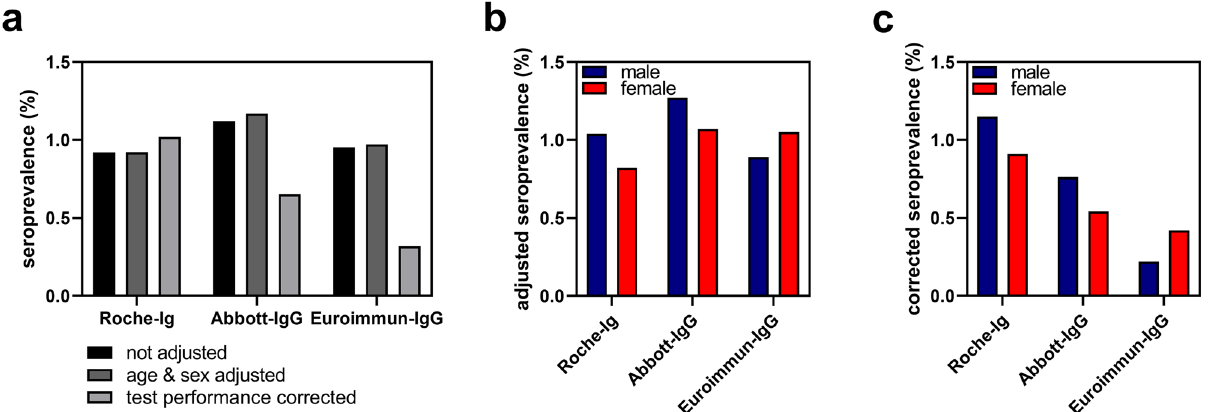
Fig. 5 Comparison of unadjusted, age- and sex-adjusted seroprevalences as well as corrected seroprevalences. a Comparison of results obtained with Roche-Ig, Abbott-IgG and Euroimmun-IgG assays. b Sex- and age-adjusted seroprevalence data of males and females. c Seroprevalences of males and females corrected for sensitivity and speci fi city. For correction, validation data from PEI were used (Table 1) 16 . 95% con fi dence intervals are shown in Supplementary Table